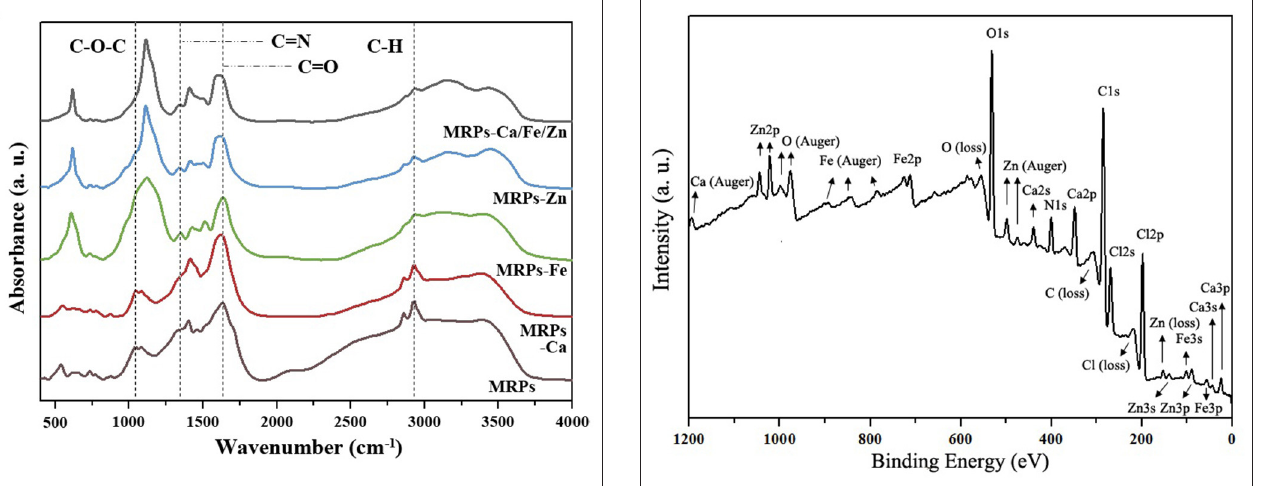
FIGURE 3 | Fourier transform infrared (FTIR) spectra of MRPs, MRPs–Ca, MRPs–Fe, MRPs–Zn, and MRPs–Ca/Fe/Zn. FIGURE 4 | X-ray photoelectron spectroscopy (XPS) spectrum of